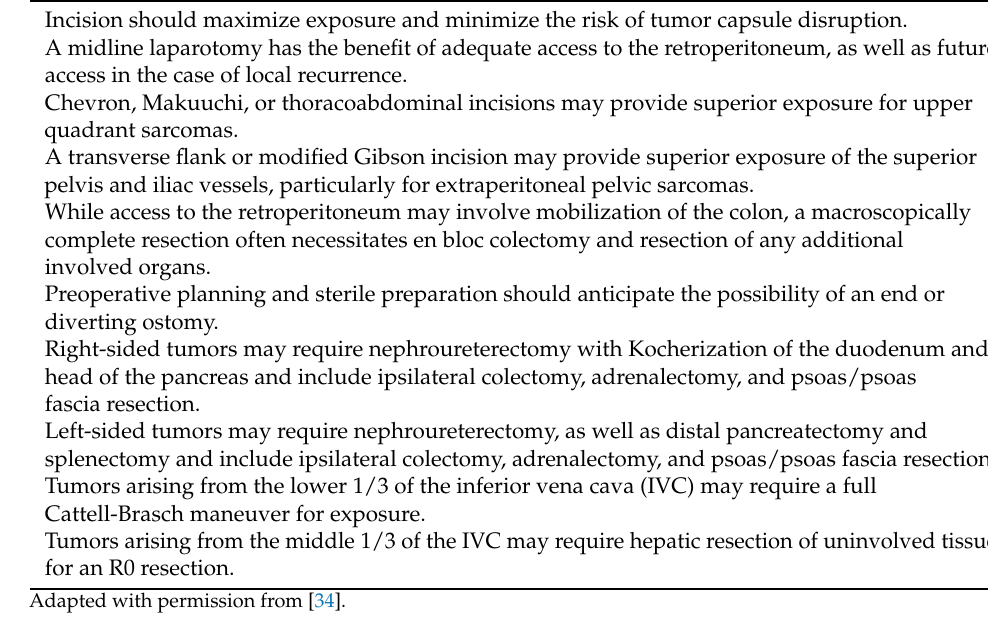
Table 1. Brief Technical Principles of Retroperitoneal Sarcoma